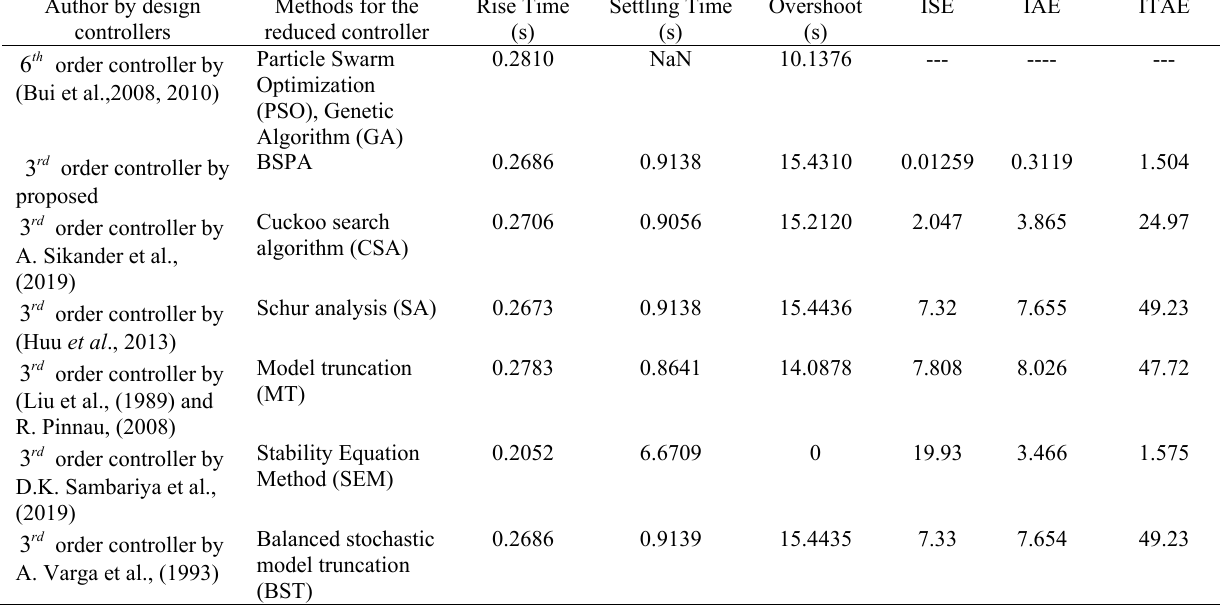
Table 4: Response comparison of HOC with ROC of without bicyrobo Author by